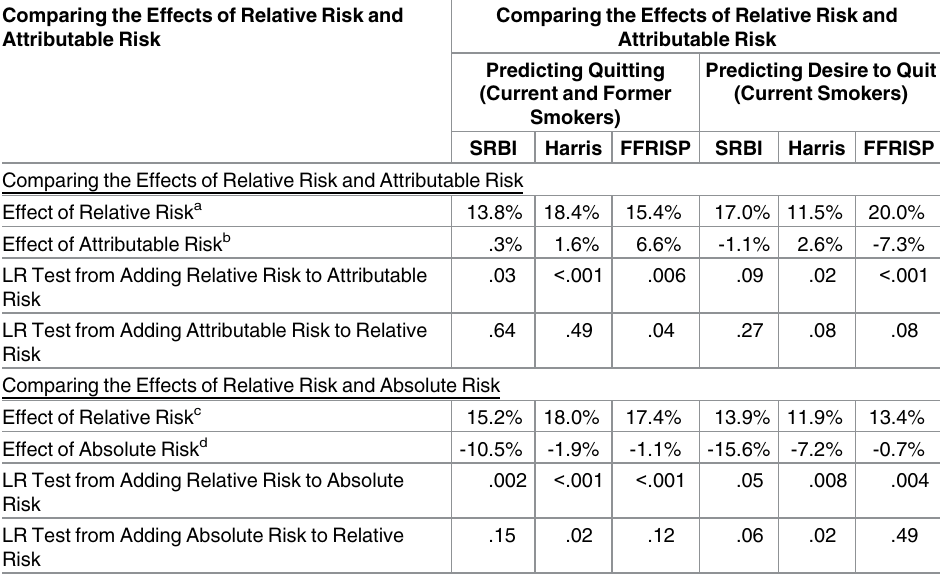
Comparing the Effects of Relative Risk and Attributable Risk Predicting Quitting Predicting Desire to Quit (Current and Former (Current Smokers) Smokers) SRBI Harris FFRISP SRBI Harris FFRISP